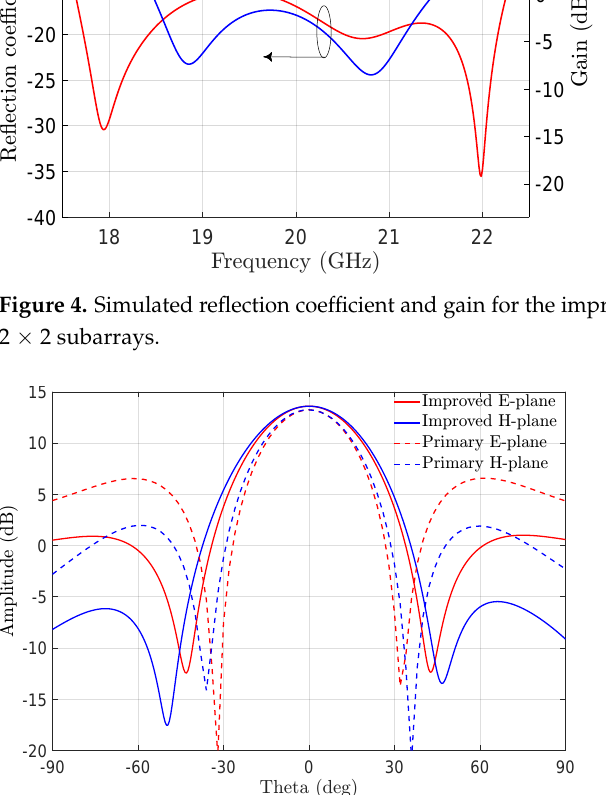
Figure 5. Radiation patterns for the improved (solid line) and primary (dashed line) 2 × 2